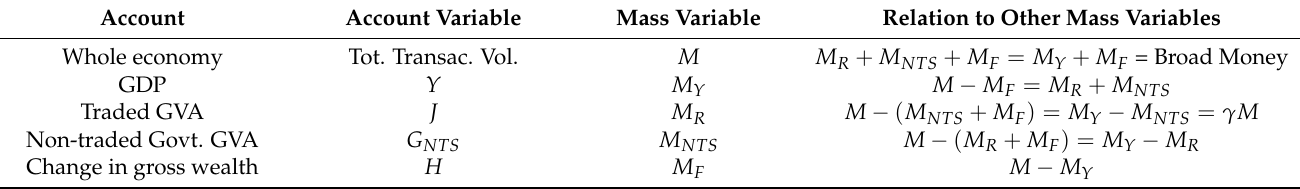
Table 3. Monetary mass variables associated with different economic accounts during one circulation. Account Account Variable Mass Variable Relation to Other Mass Variables Whole economy Tot. Transac. Vol.